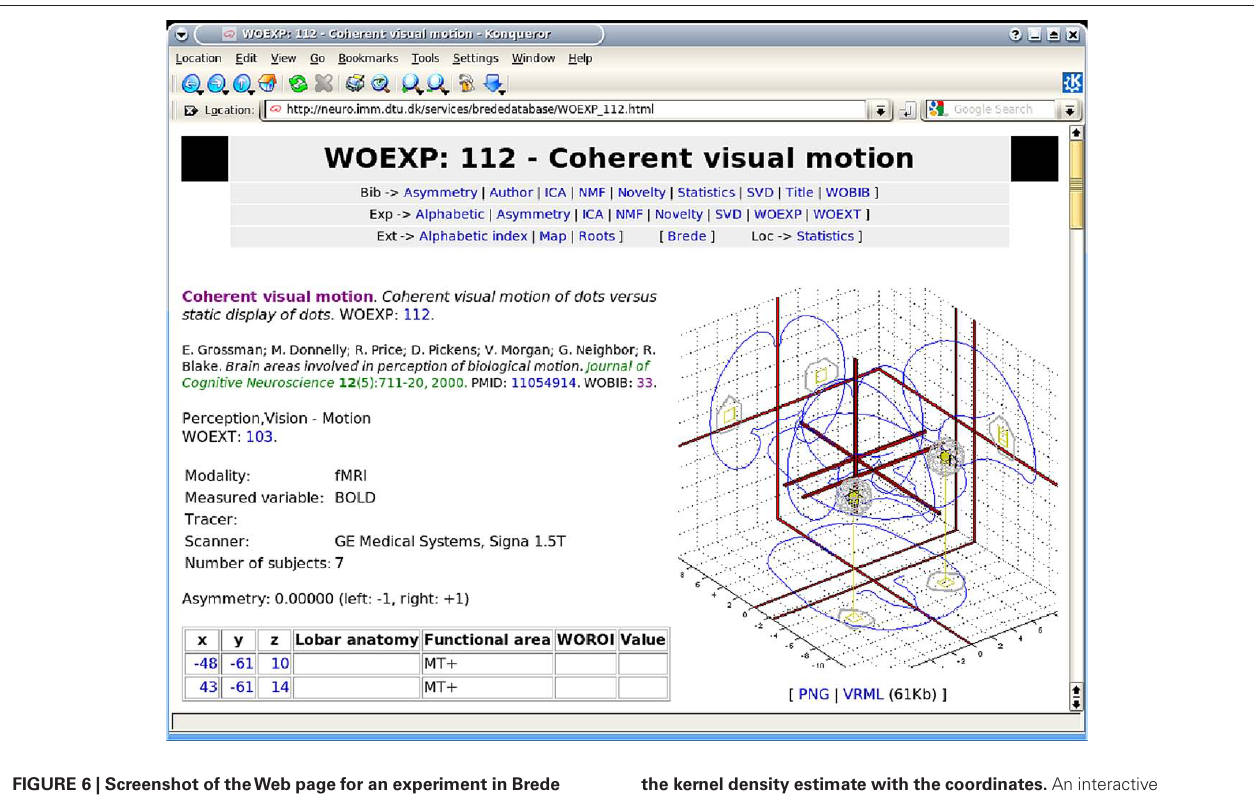
the kernel density estimate with the coordinates. An interactive rendering is provided with the link to a generated corner cube visualization in a VRML fi